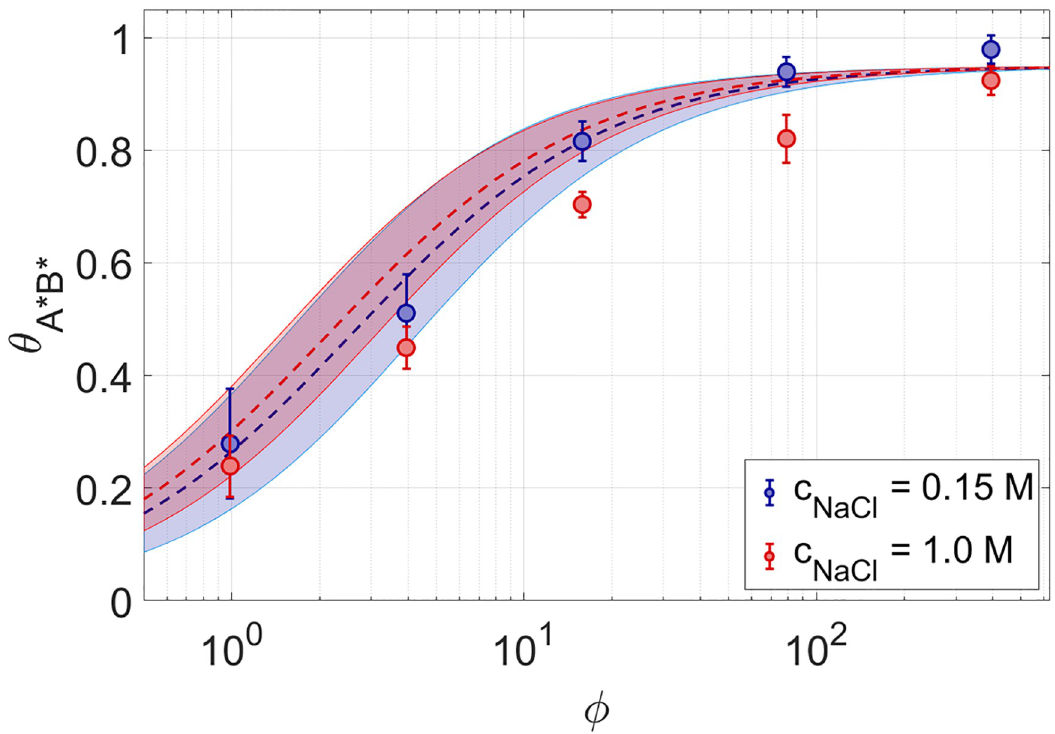
Fig 9. Probability of defectless duplexes in rsDNA: Salt dependence. Fraction of paired 8 A � 8 B � as a function of ϕ , expressing their dilution in 8N, at T = 15˚ C for c = 0.15 M (blue dots) and c = 1.0 M (red dots). Dashed lines: theoretical predictions, with the NaCl NaCl shaded regions obtained from the experimental uncertainty on the pairing energy between A � B � , (see S2 Text).